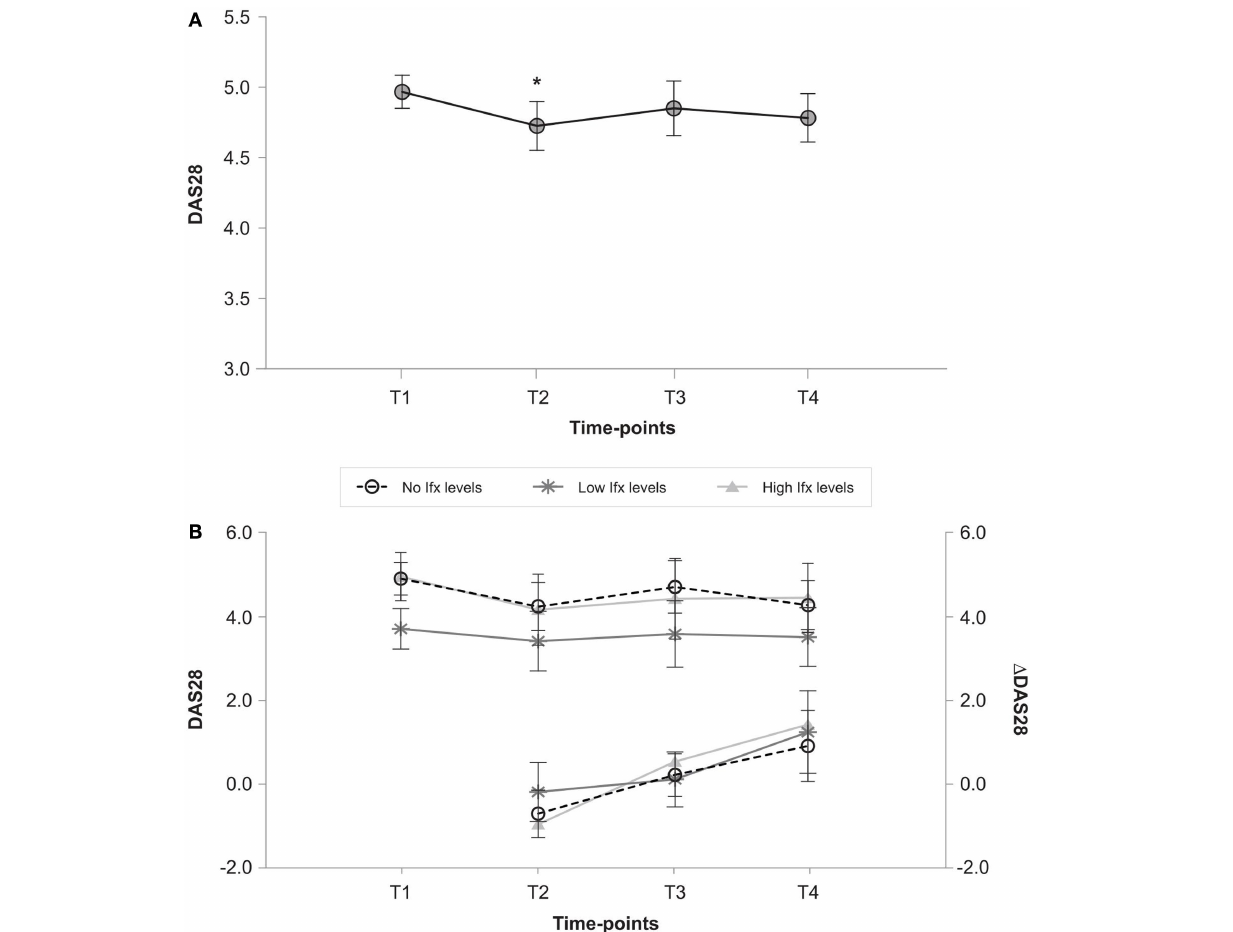
Frontiers in Medicine |